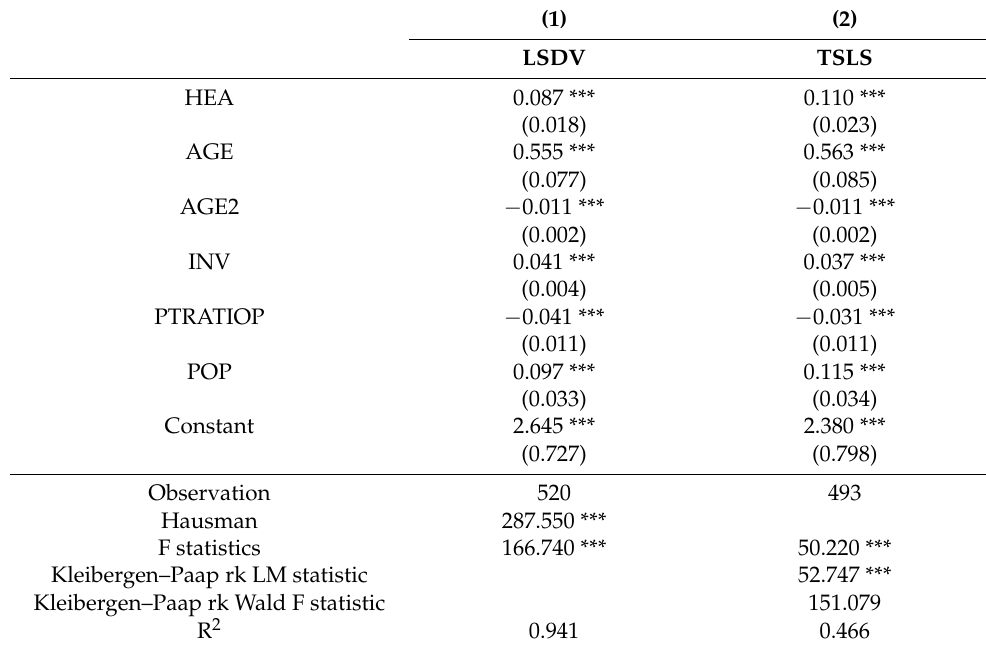
Table 4. Heterogeneity analysis: Samples from 40 European